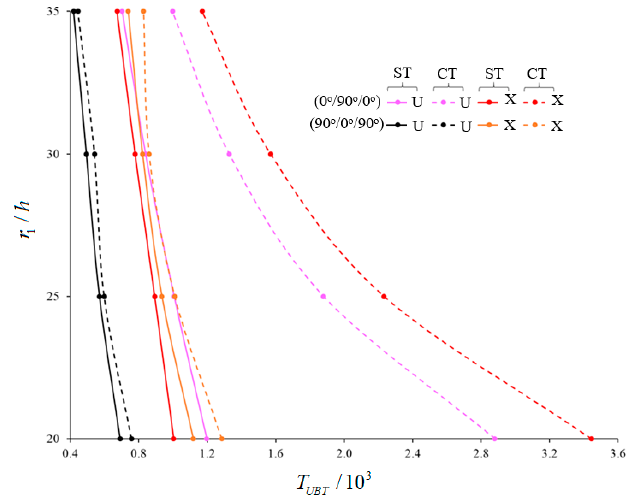
Figure 4. Variations of UBT for (90°/0°/90°) ‐ and (0°/90°/0°) ‐ array laminated cones with U ‐ and X ‐ shaped layers for Cos ‐ Hyp ‐ TSS function (within CT versus 1 / r h ).